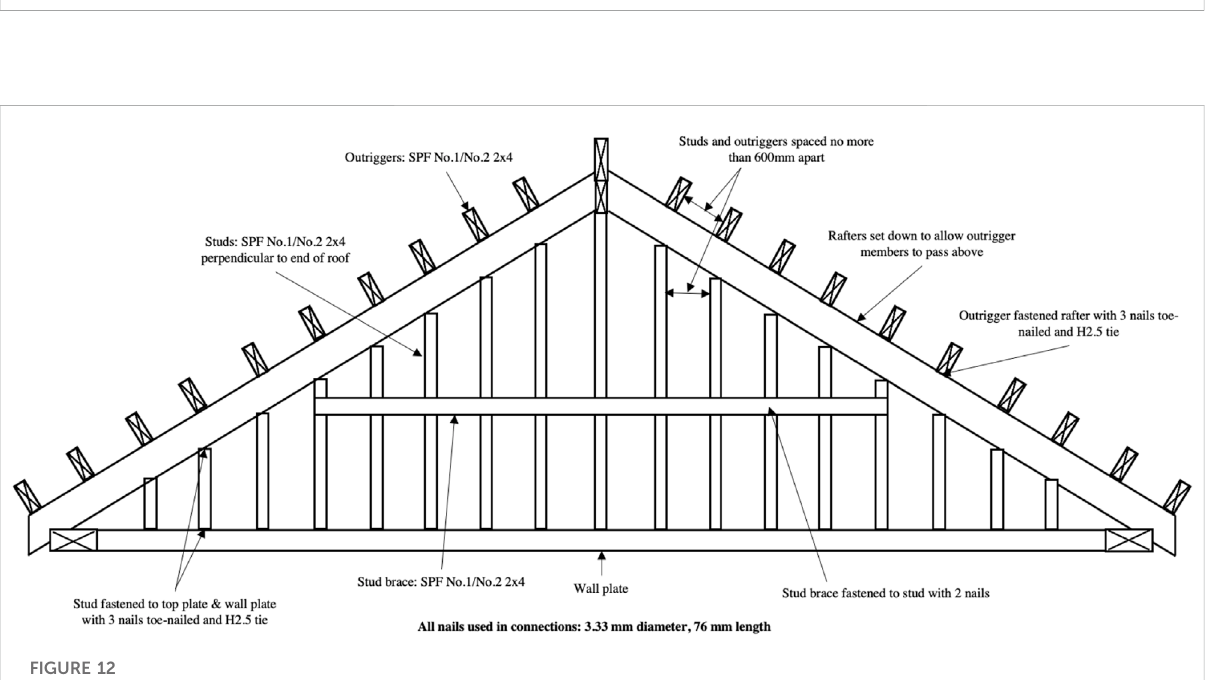
FIGURE 12 The recommended connections and members in the gable end